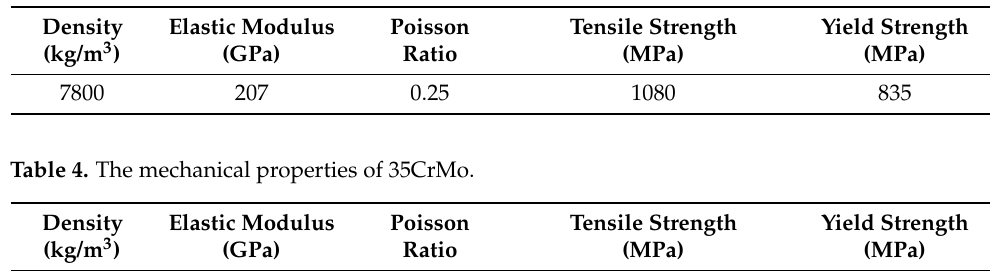
Table 3. The mechanical properties of 20CrMnTi.